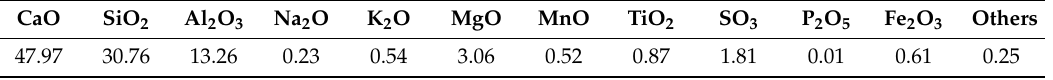
Table 1. Chemical composition (oxides in wt.%) of ground-granulated blast-furnace slag (GGBFS).